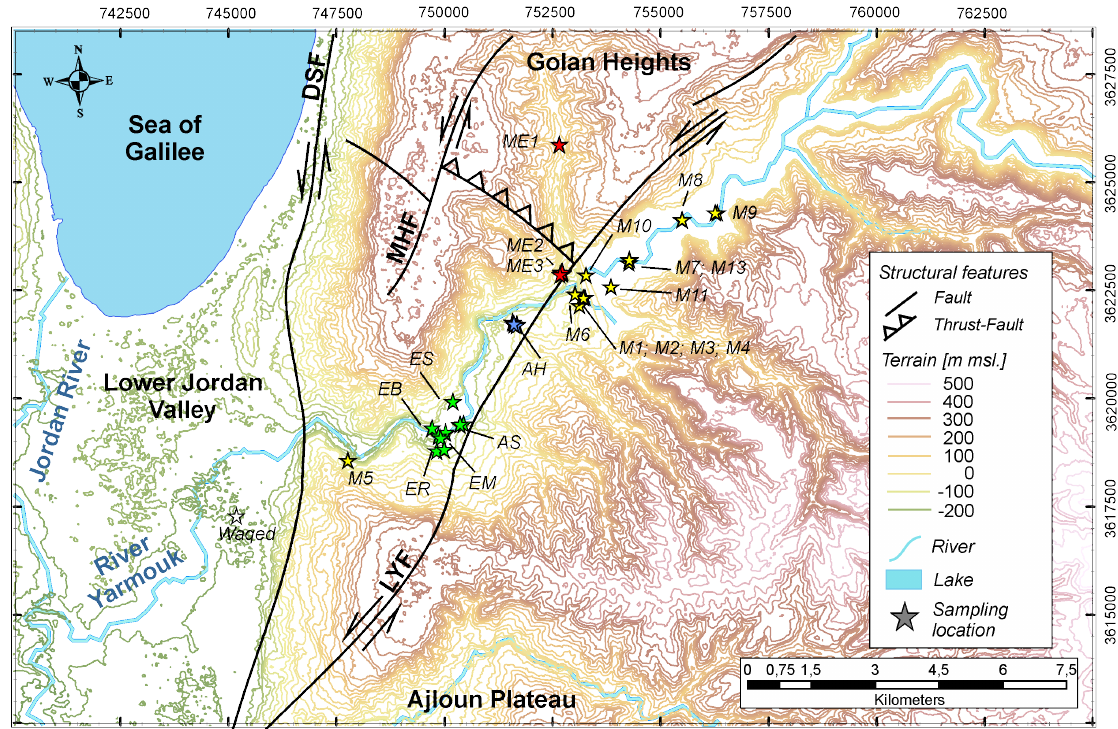
Figure 3. A detailed view of the sampling locations in the Lower Yarmouk Gorge. Very important are the Lower Yarmouk (LYF) and Mevo Hamma faults (MHF) and the rise of the Hammat Gader block in between. DST= Dead Sea fault. The region of Hammat Gader encloses codes, EB, ER and EM (Table 1). Color codes of stars: yellow—Mukheibeh well field; red—Mezar well field; green—Hammat Gader; blue—Ain